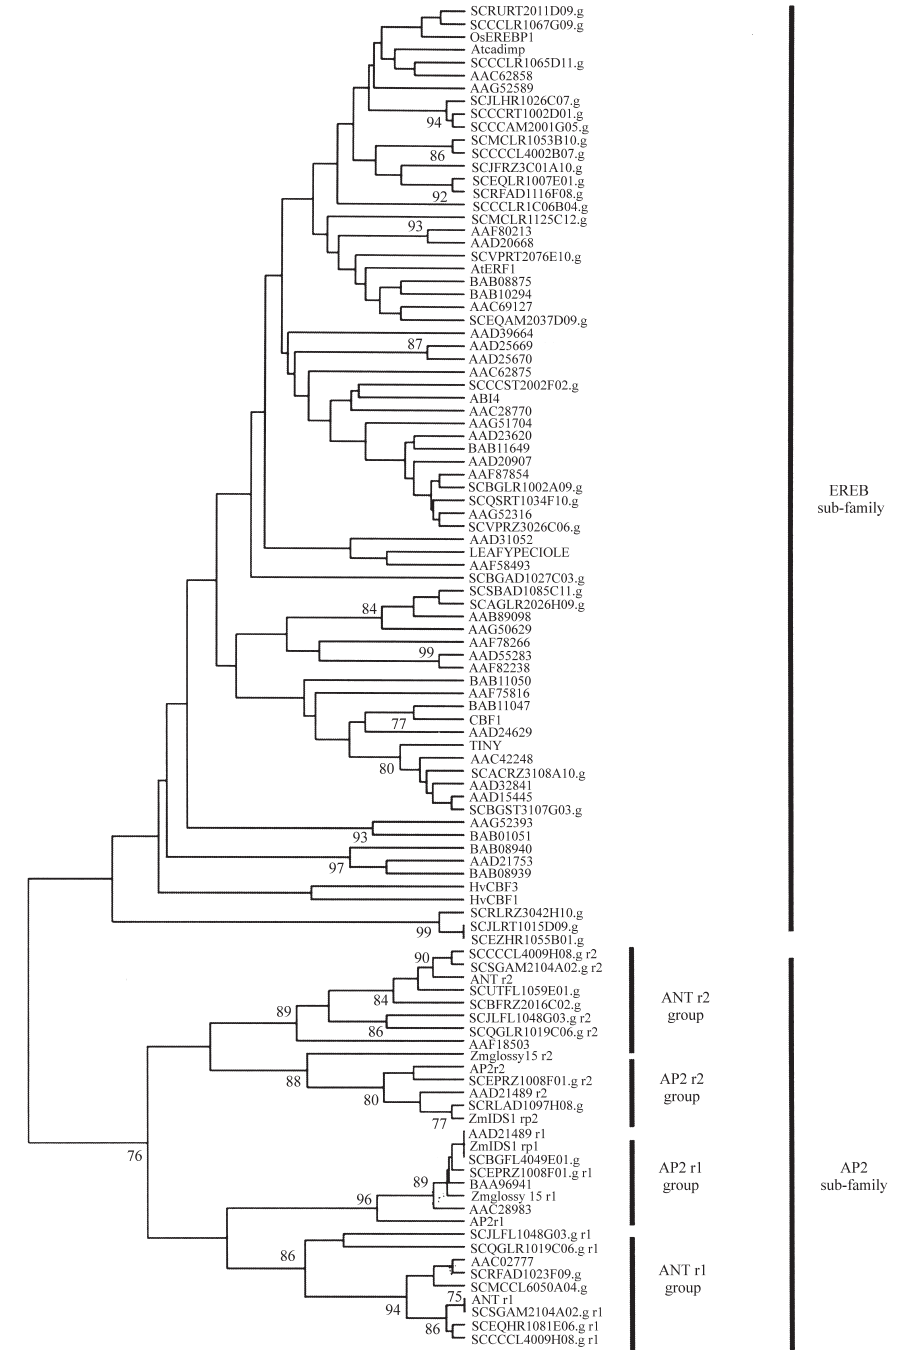
Figure 4 - Phylogenetic relationships of the sugarcane AP2 transcription factors and their putative homologues from Arabidopsis . The most parsimoni- ous consensus tree resulted from the branch-and-bound algorithm. Trees with similar topology were also obtained using a distance matrix and neigh- bor-joining. Only Bootstrap values (1000 replicates) higher than 75% are shown. The r1 and r2 labels indicate the two tandem AP2 domains of a same protein that were analyzed separately. For reference numbers and references to the gene sequences used, see